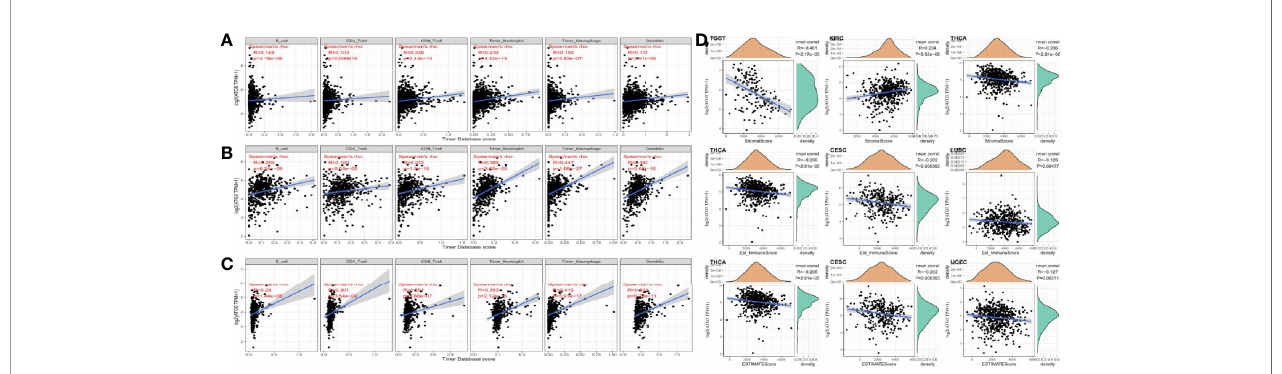
FIGURE 4 | Correlation analysis between ATG5 expression in Pan-cancer and tumor immune in fi ltration and tumor microenvironment. (A) Correlation analysis between expression levels of ATG5 and immune cell in fi ltration in BRCA. (B) Correlation analysis between expression levels of ATG5 and immune cell in fi ltration in KIRC. (C) Correlation analysis between the expression level of ATG5 and immune cell in fi ltration in LIHC. (D) Correlation analysis between ATG5 expression in Pan- cancer and immune score, between ATG5 expression and stromal score, and between ATG5 expression and estimate